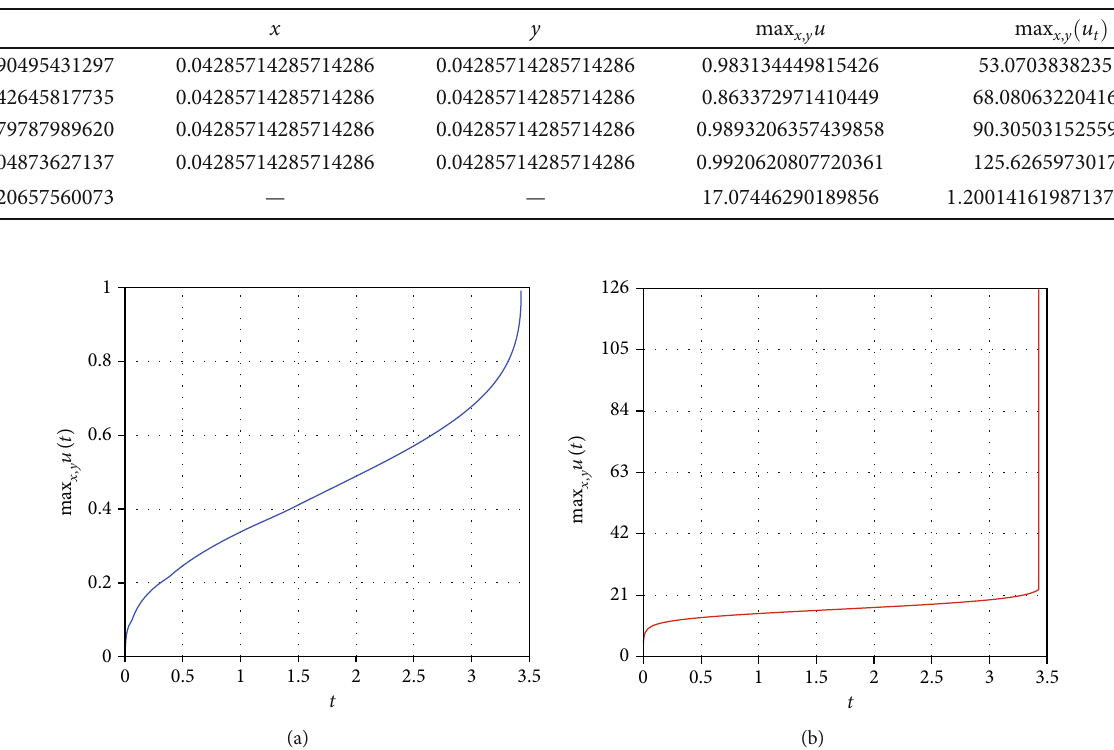
max u as t increases, and (b) max t : (a) x , y